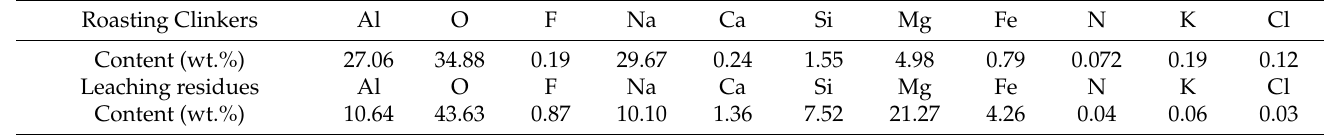
Table 4. Compositions of the roasting clinkers and the leaching residues under optimal conditions